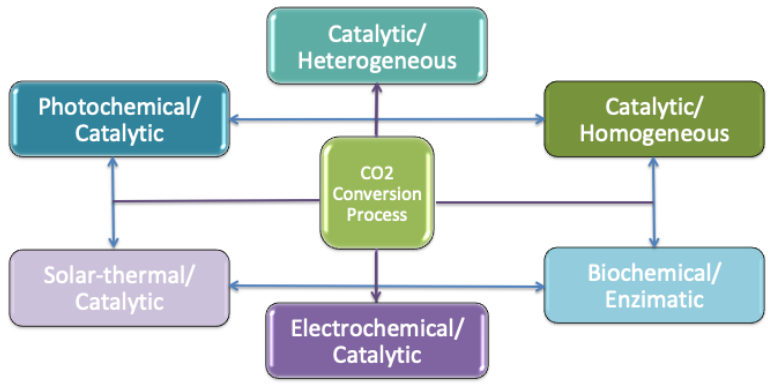
Figure 2. General structure of a cyclic carbonate ( a ) and examples of commonly produced cyclic carbonates ( b